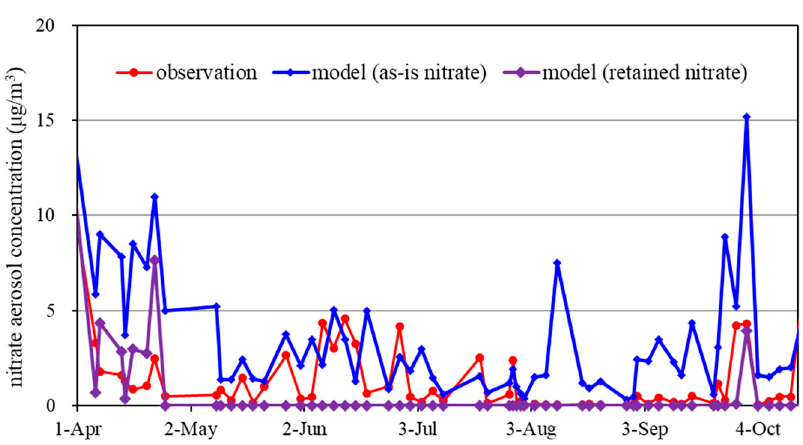
Figure 12. Comparison of the nitrate observation and the nitrate forecast at the Bulkwang site in Seoul from April to November 2016.